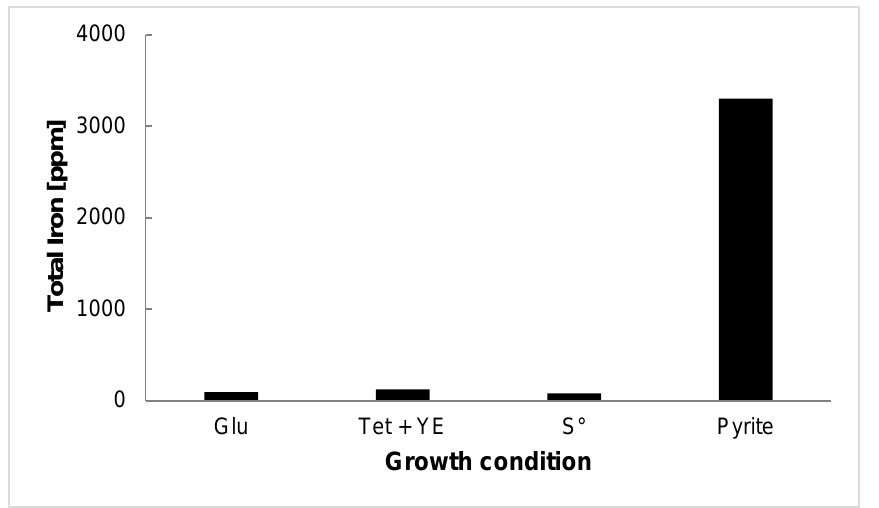
Figure 5. Bioleaching of pyrite by A. copahuensis cells pre-grown with glucose, tetrathionate and yeast extracts, sulfur, or pyrite after 10 days of cultivation.